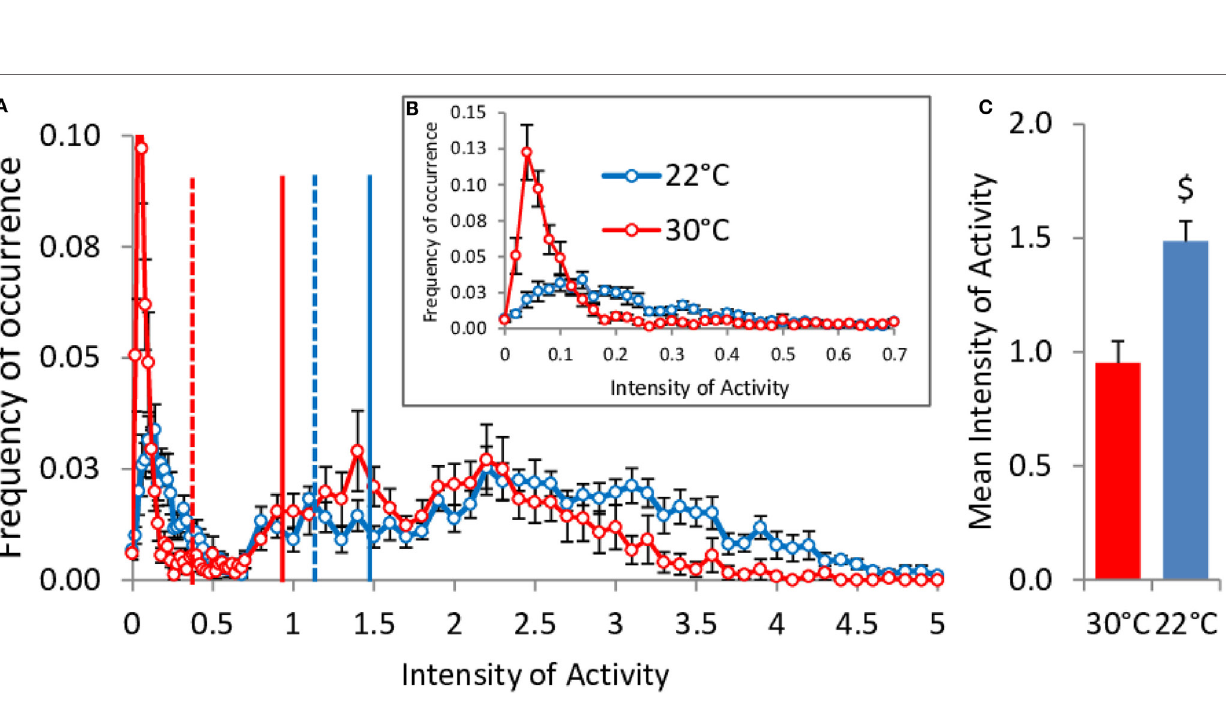
FigUre 9 | activity values distribution in ad libitum fed mice housed at 30°c ( n = 9) and 22°c ( n = 11) . Vertical lines: mean (solid) and median (dashed). (a) Overall distribution of the activity values ( P < 10 − 6 22°C vs. 30°C). Inbox (B) , zoom of the distribution on the lower intensities of activity values. (c) Mean activity values ($, P <